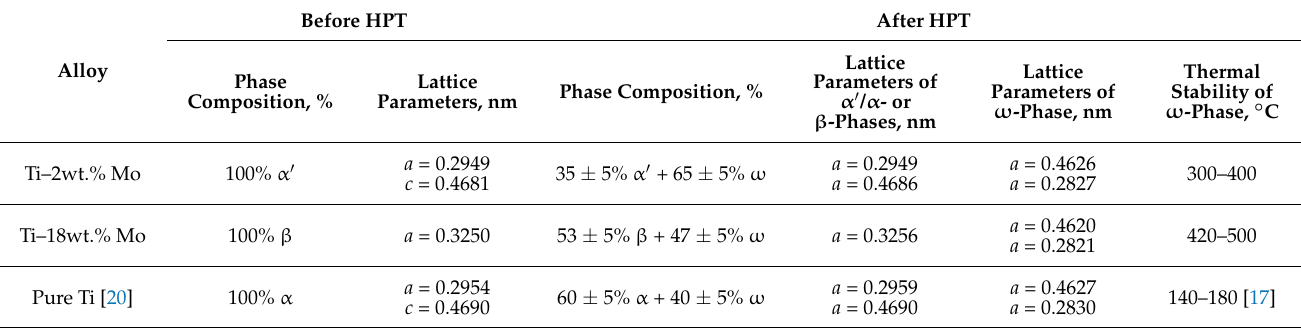
Table 3. The volume fraction and lattice parameters of some phases before and after HPT as the thermal stability of the ω -phase measured by the XRD in situ